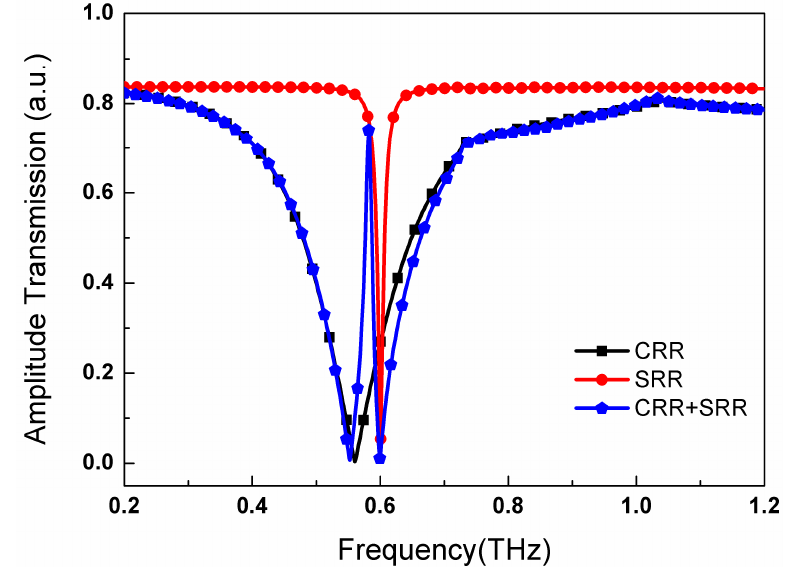
Figure 3. The simulated amplitude transmission spectra of the closed-ring-resonator (CRR), the split-ring-resonator (SRR), and both of them.